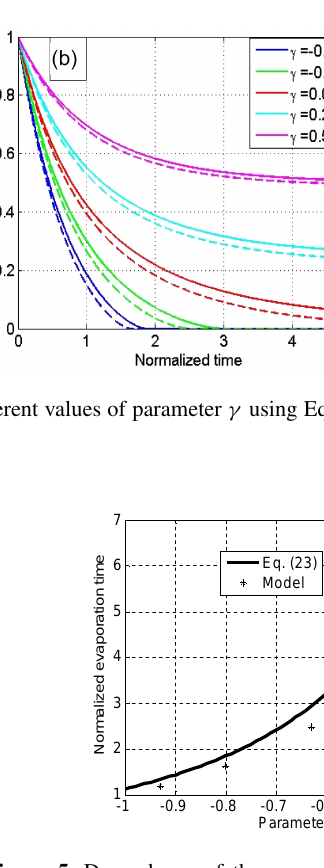
Figure 5. Dependence of the evaporation time on parameter χ , t e (χ) . Time is measured at the relaxation timescales. The values obtained using a parcel model are shown by